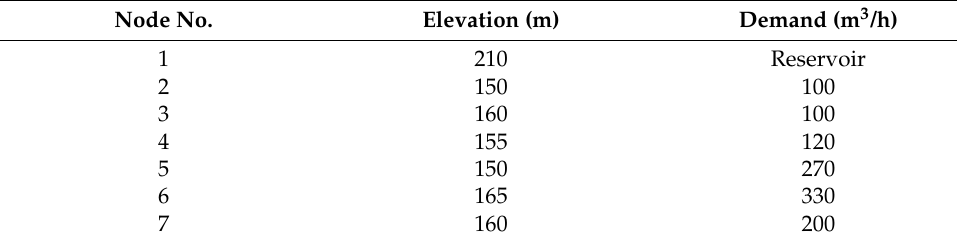
Table A1. Node data for the Two-loop network.